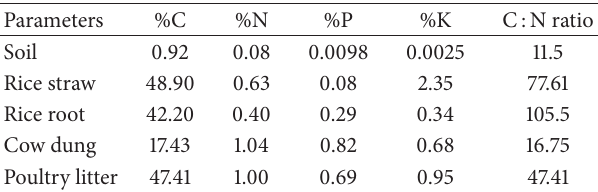
Table 1: Characteristics of organic residues and